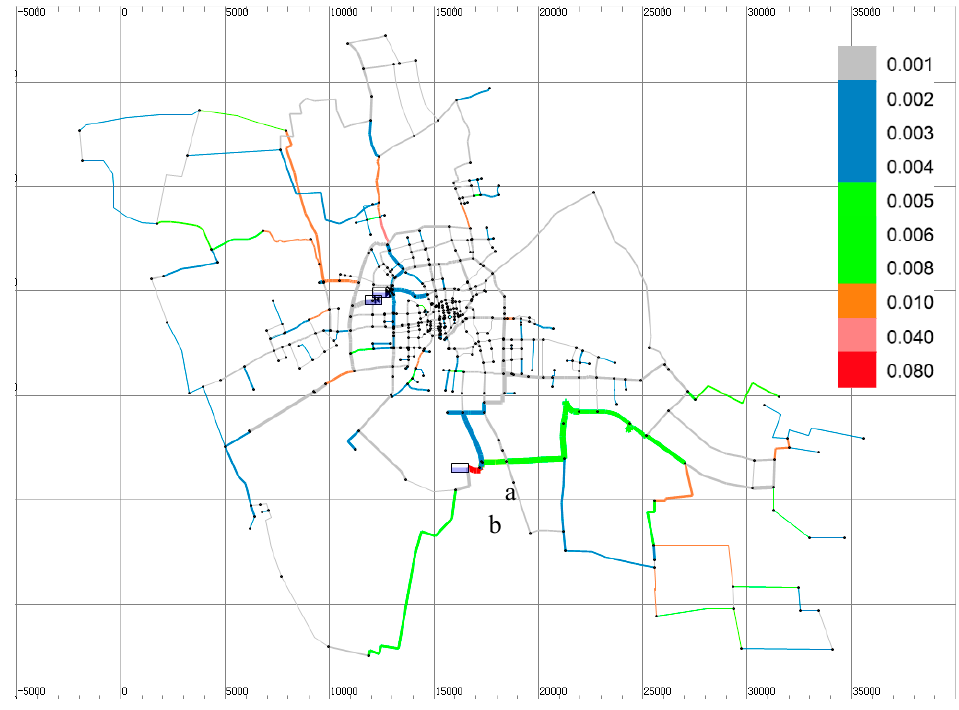
Figure 3. The global UIPF of WDS.